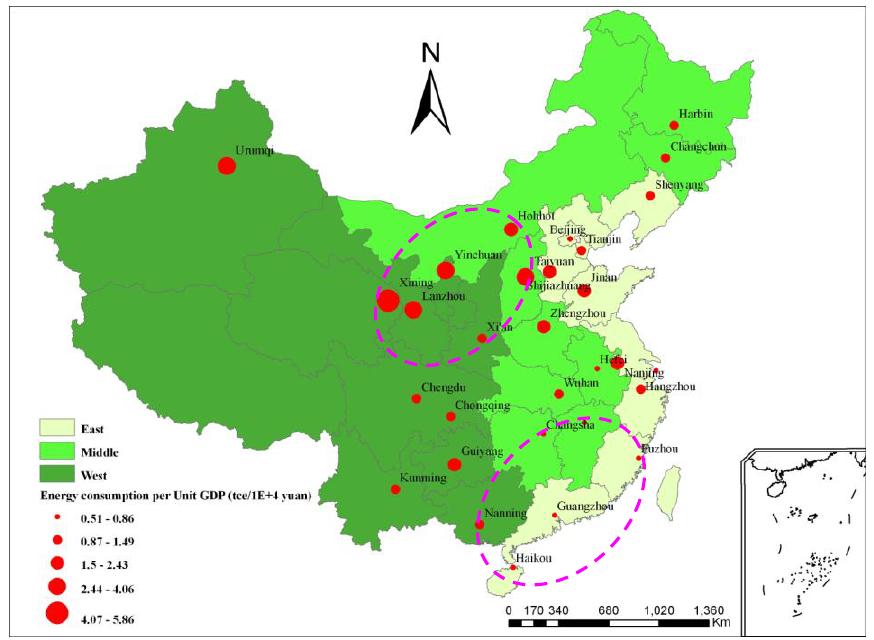
Figure 4. Energy efficiency for the 30 provincial capital cities of mainland China in